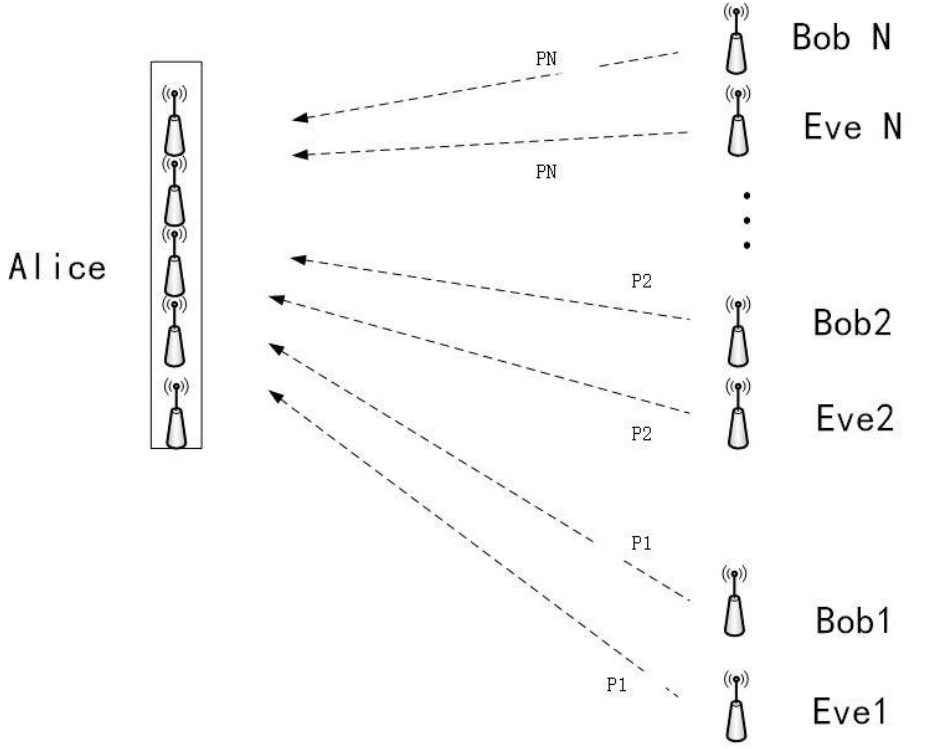
Figure 3. Single-antenna eavesdroppers launch pilot spoofing